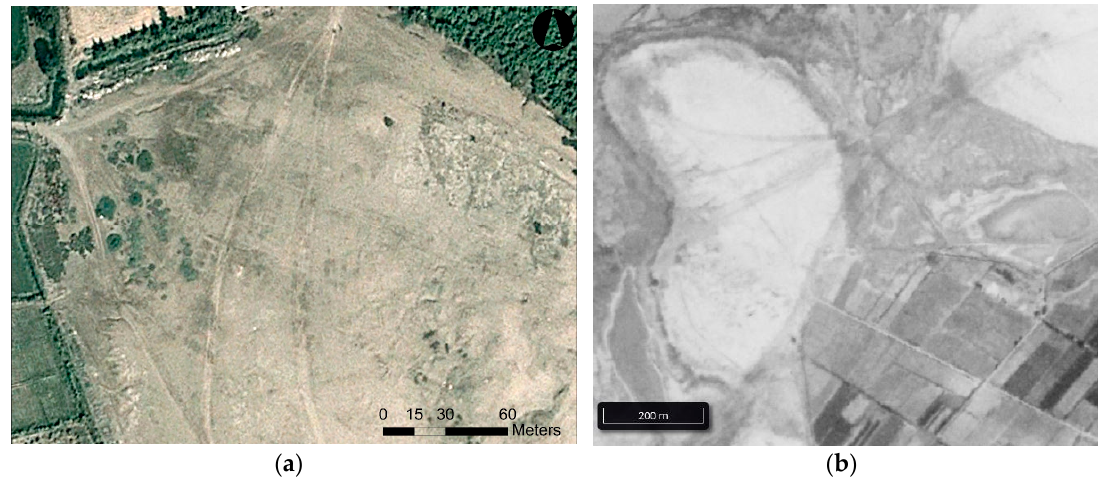
Figure 8. ( a ) The site of Daba el-Qibli . Image courtesy Google Earth; ( b ) 1968 CORONA image. Image courtesy of the Center for Advanced Spatial Technologies, University of Arkansas/U.S. Geological Survey.